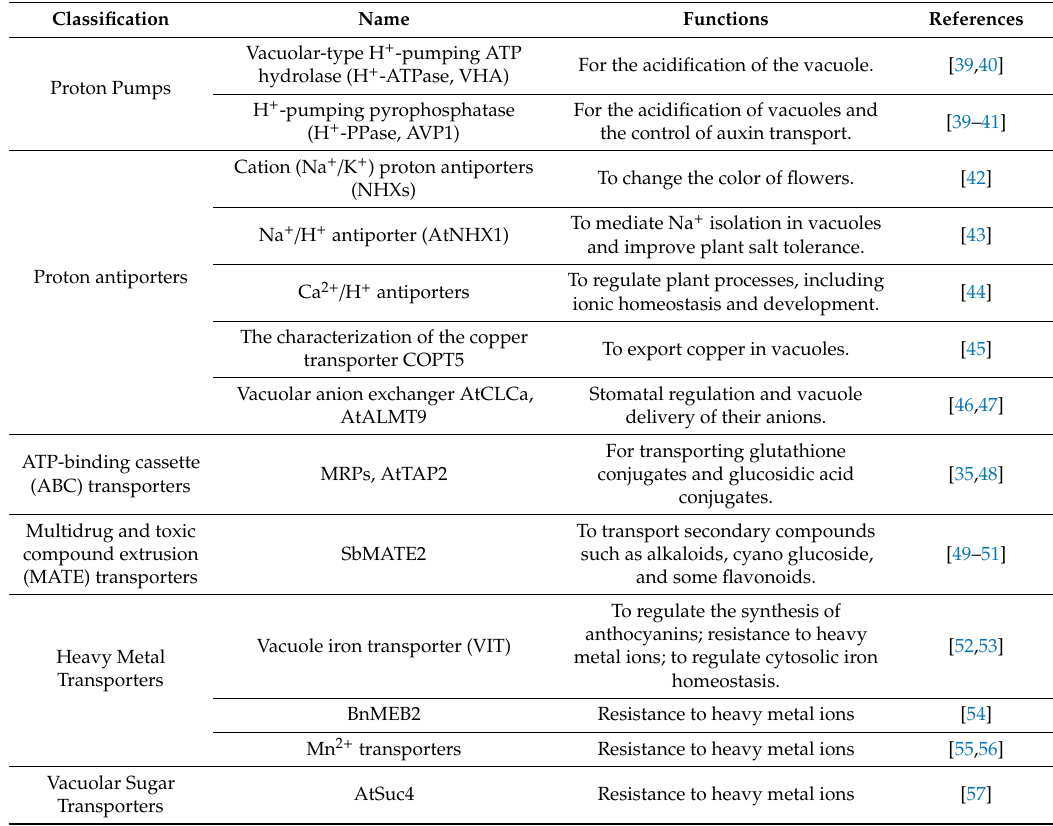
Table 1. Partially localized proteins on